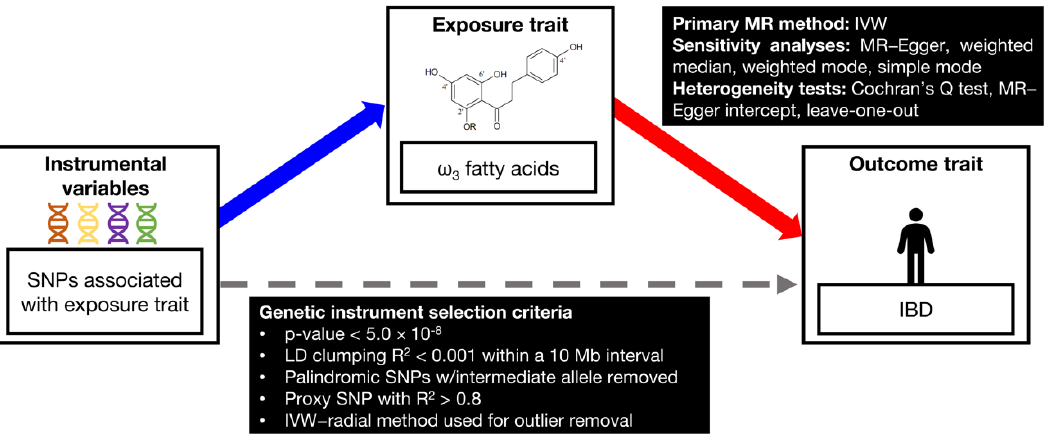
Figure 5. Methodology depicting the MR study design for selecting ω 3 fatty acid genetic instruments and assessing the causal relationship between circulating ω 3 fatty acids on IBD.